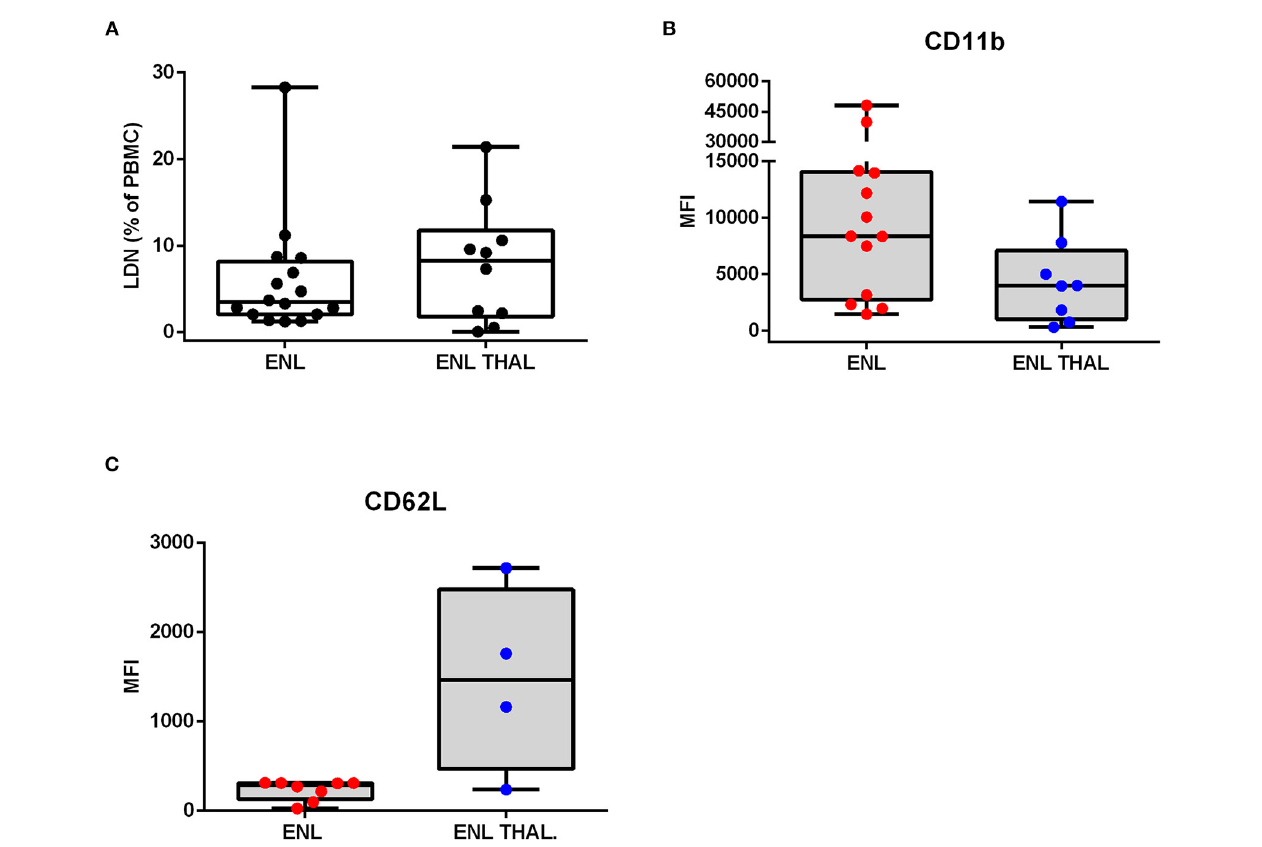
FIGURE 4 | Frequency and phenotypic analyses of low-density neutrophils in ENL patients undergoing thalidomide treatment. ENL patients were analyzed at diagnosis (ENL) and seven days after starting thalidomide treatment (ENL THAL). (A) Frequency of LDNs in the PBMC layer of ENL ( n = 16) and ENL THAL ( n = 10) patients. MFI was calculated by subtracting the MFI from the FMO control sample for each LDNs marker. (B) CD11b expression on ENL ( n = 13) and ENL THAL ( n = 8) patients. (C) CD62L expression on ENL ( n = 8) and ENL THAL ( n = 4) patients. Box plots show median; interquartile range; and sample minimum and maximum. Dots represent individual patients. Statistic: (A–C) Mann–Whitney.